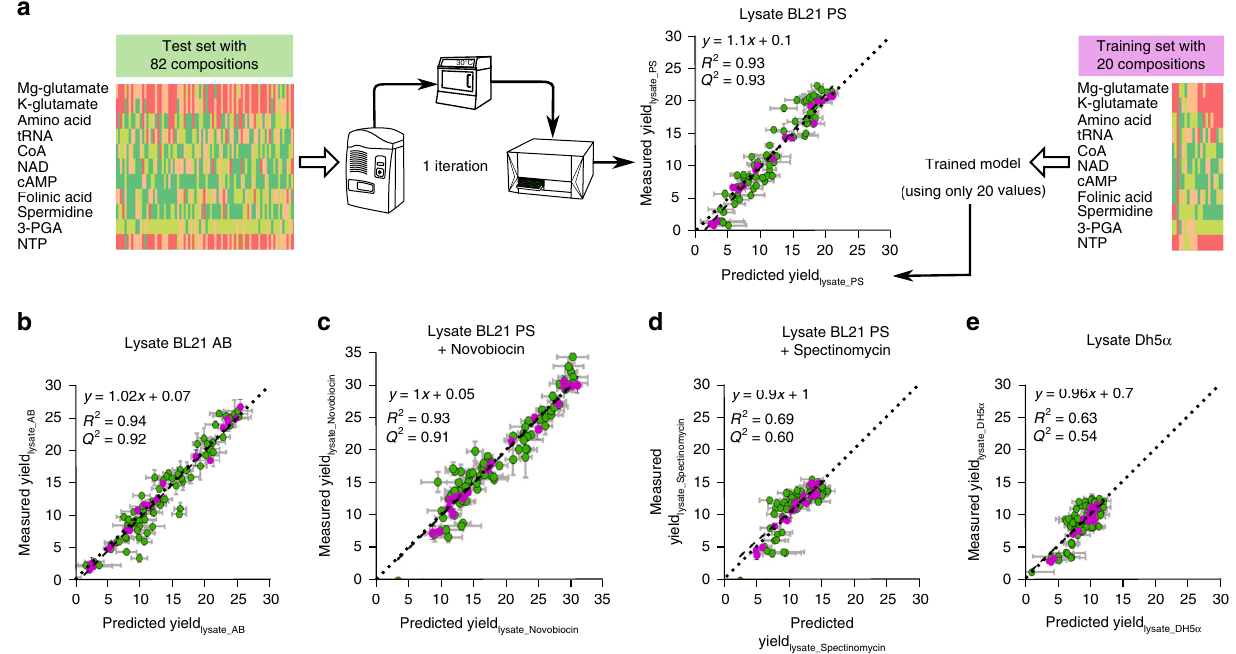
Fig. 4 One-step method to predict protein yield in cell-free systems. a Illustration of the method used to predict the yield of protein expression with a new lysate, labeled PS, made by another experimentalist. The training of the model is based on yield measurements of 20 buffer compositions (magenta circles). The choice of the 20 buffers combinations leading to the best predictions is described in the methods. The yields obtained with 82 compositions (green circles) were measured and compared to the model predictions to test its accuracy ( R 2 value was computed on 102 values, Q 2 on the 82 values of the test set, the linear regression fi ts the 82 test values). The yield is speci fi c to each lysate as the reference composition used the same chemicals concentration as in Fig. 1 but with different lysate. b Comparison of the yields obtained with the lysate AB (made by a third experimentalist) vs. the model predictions. c Comparison of the yields obtained with the lysate, of panel a, supplemented with 0.25 mg/mL of novobiocin vs. the model predictions. d Comparison of the yields obtained with the lysate of a , supplemented with 0.5 mg/mL of spectinomycin vs. the model predictions. e Comparison of the yields obtained with a lysate obtained from the strain DH5a vs. the model predictions. In all panels, the model predictions are based on a model trained with the same 20 buffer compositions and the same test set of 82 buffer compositions only lysate differs. In all panels, the data are mean and the horizontal gray lines stand for the standard deviation of three replicates. The horizontal gray lines stand for the standard deviation of 25 predictions and the vertical gray lines correspond to the standard deviation obtained on three replicates. Source data are provided in the Source Data fi